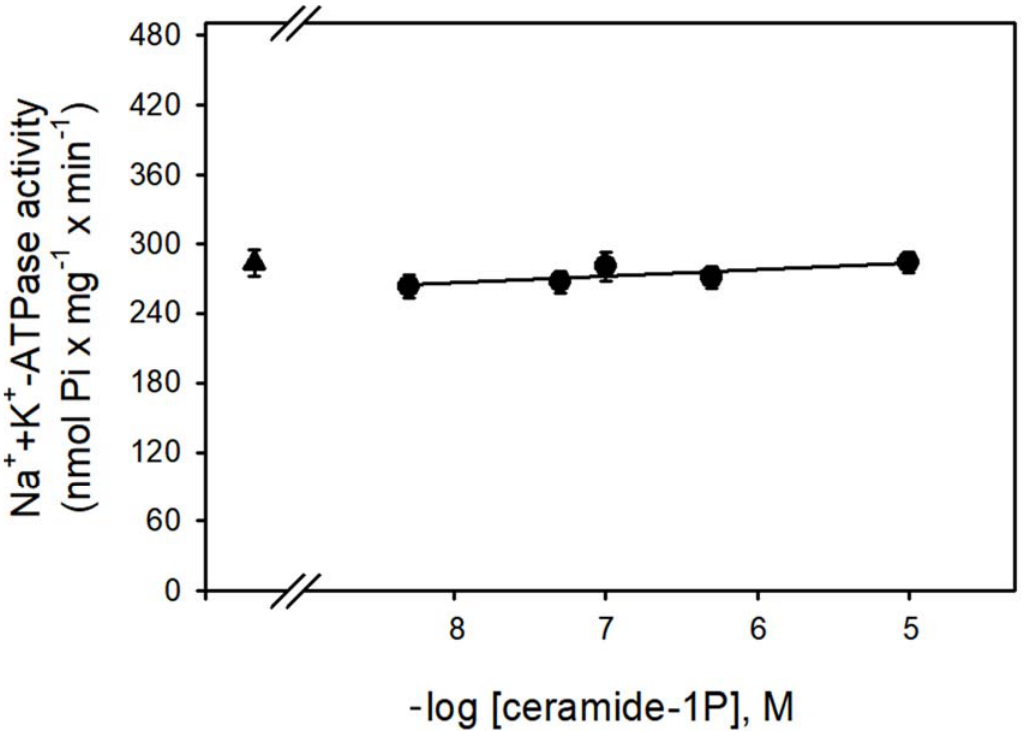
Figure 2. The BLM Na + /K + -ATPase was not modulated by C1P. The Na + /K + -ATPase activity was determined as described in the Material and Methods, in the presence of crescent C1P concentrations shown on the abscissa. Data are means ± SE of at least six experiments performed in triplicate with different kidney membrane preparations. Triangle: control without C1P.